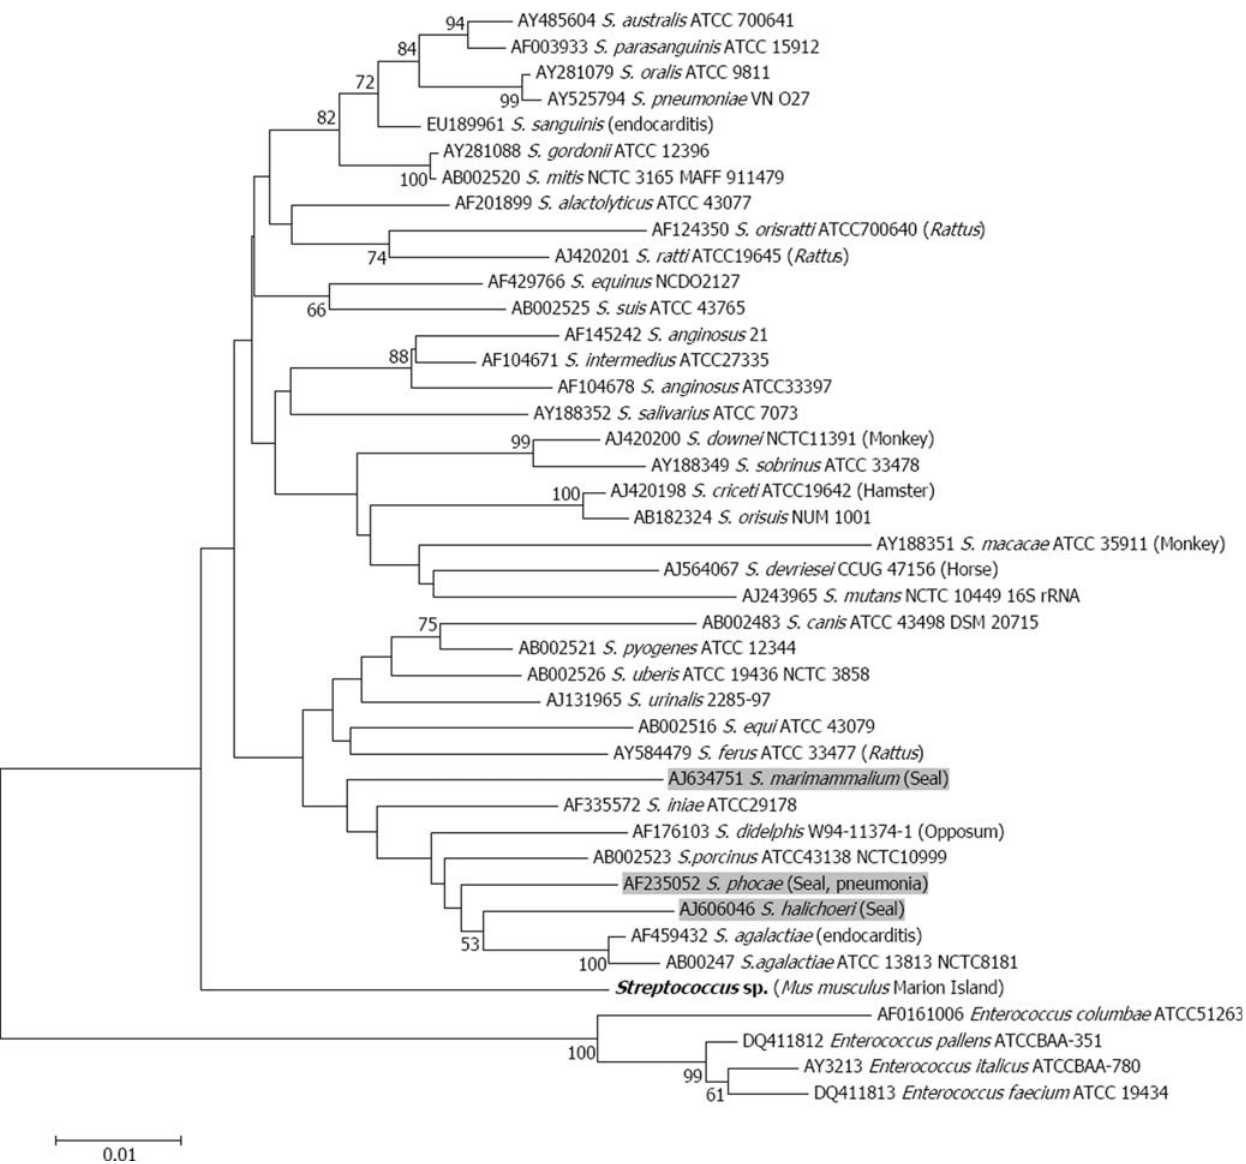
Figure 2. Bacterial 16S gene neighbor-joining phylogram depicting the genetic relatedness of the Streptococcus species in Marion mice kidneys (indicated in bold) to other Streptococcus species, including those identified in pinnipeds (indicated in grey shading). Bootstrap support values . 50 are indicated next to the relevant nodes and taxon names comprise Genbank number, bacterial species, type specimen/strain information (where available) followed by host and/or disease information in brackets.